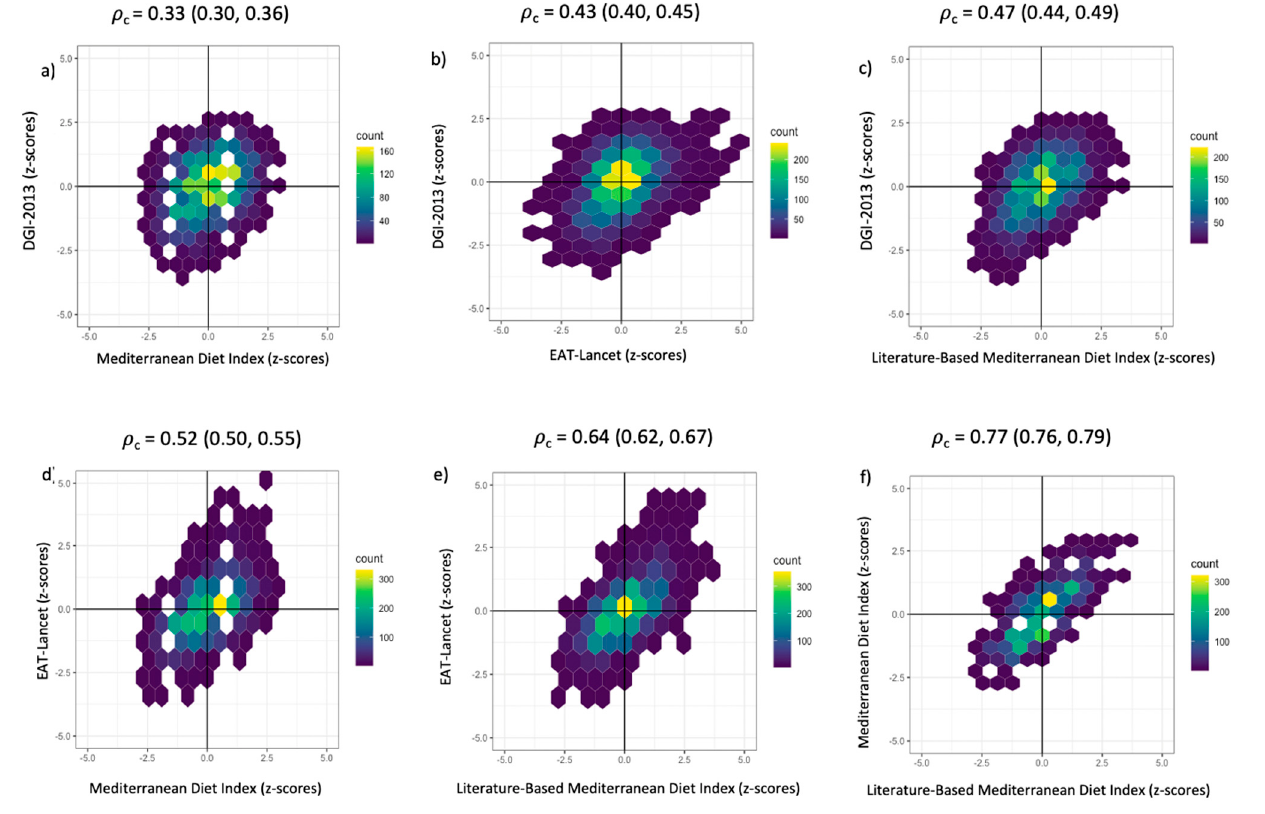
Figure 3. ( a – f ). Density hexabin plots with z-scores of the dietary indices: EAT-Lancet Index, Dietary Guideline Index 2013 (DGI-2013), Mediterranean Diet Index (MedDiet) and the Literature-Based Mediterranean Diet Index (Lit-MedDiet). Lin’s concordance correlation coefficient ( 𝜌 c ) and 95% confidence intervals were calculated to measure the extent of agreement pairwise between dietary indices.